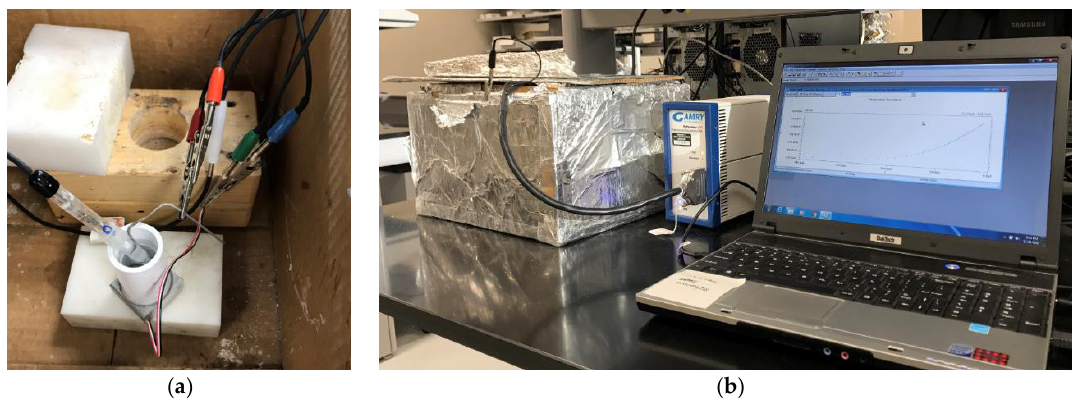
Figure 4. Electrochemical corrosion test set-up ( a ) and test layout ( b ).